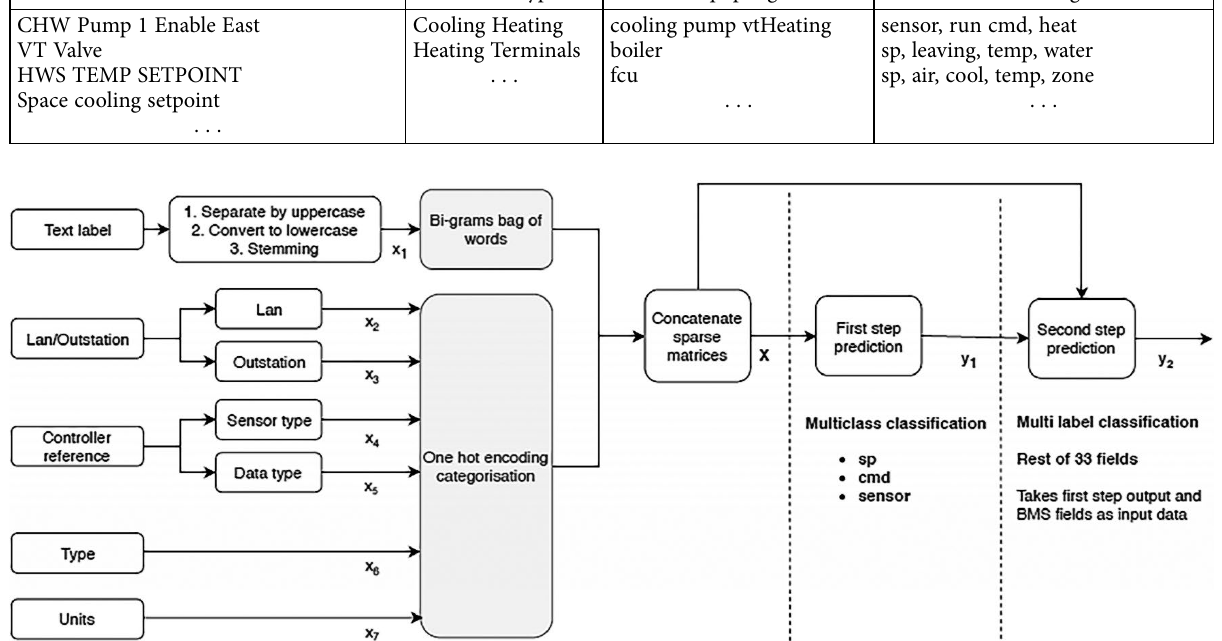
Table 4. Example of tagging problem with all categories Label